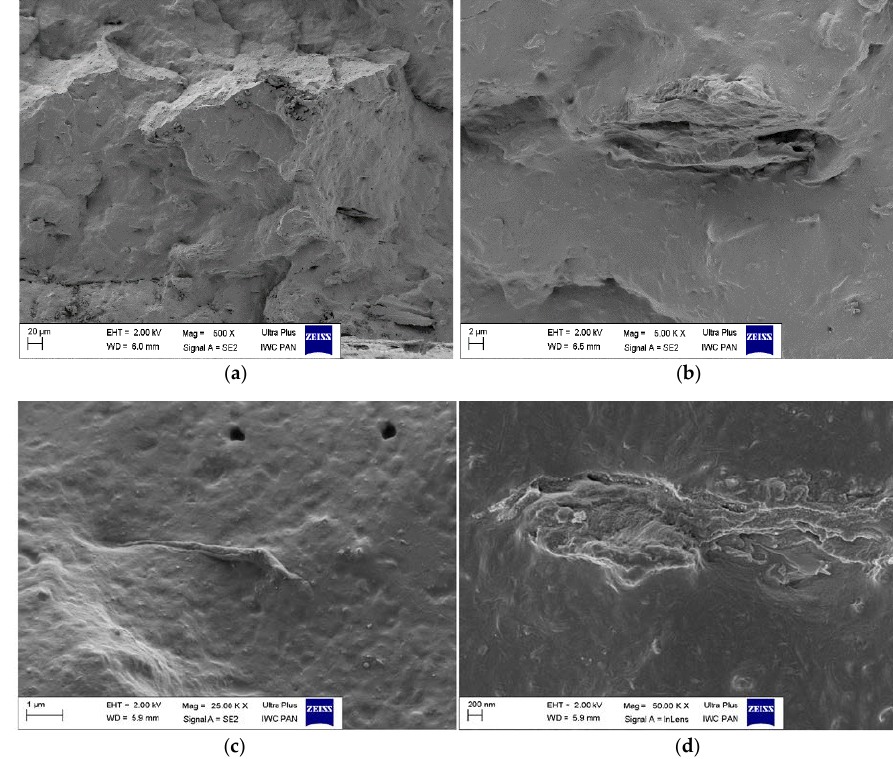
Figure 6. SEM images of biocomposites filled with 30 phr of horsetail under magnification: ( a ) 500× ( b ) 5.00× ( c ) 25.00× (d) 50.00×.